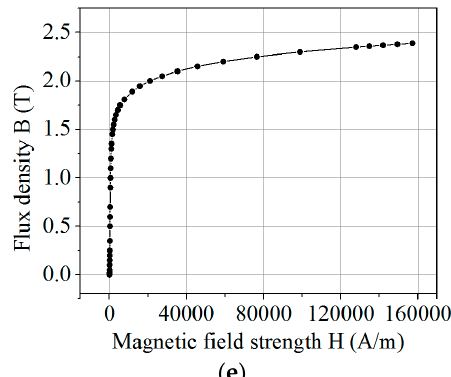
Figure 5. The finite element analysis model of the MMA. ( a ) MMA model; ( b ) mesh model; ( c ) flux distribution at excited current of 2.4 A; ( d ) magnetic flux density at excited current of 2.4 A; ( e ) B–H curve of 1020 C.